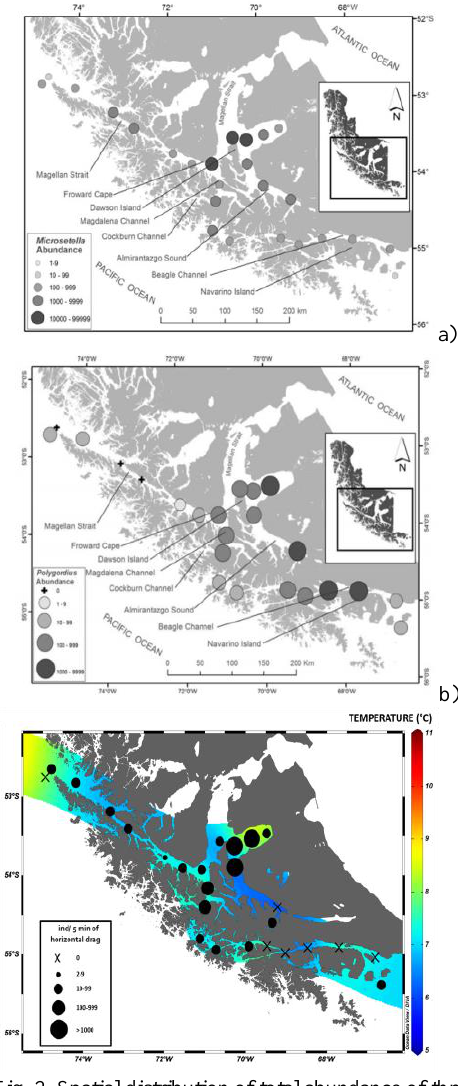
Fig. 2. Spatial distribution of total abundance of three neustonic taxa along Magellan Strait, Chile, during CIMAR 16 cruise (2010): a) copepodites of Microsetella rosea , b) larvae of the polychaete Polygordius sp, c) Cyphonautes